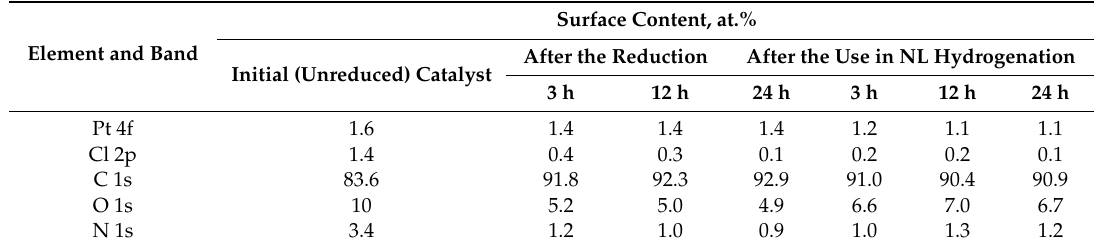
Table 1. Elemental composition of the catalyst